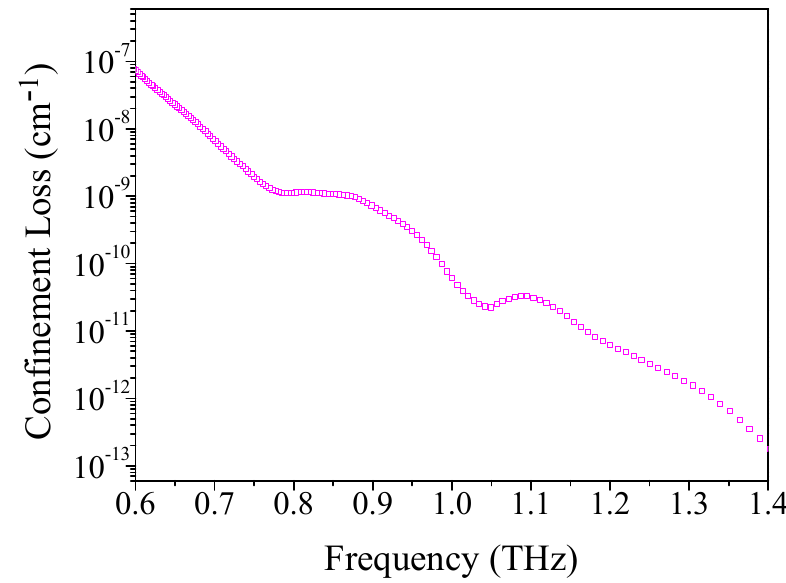
Figure 10. The relation of constraint loss with frequency.